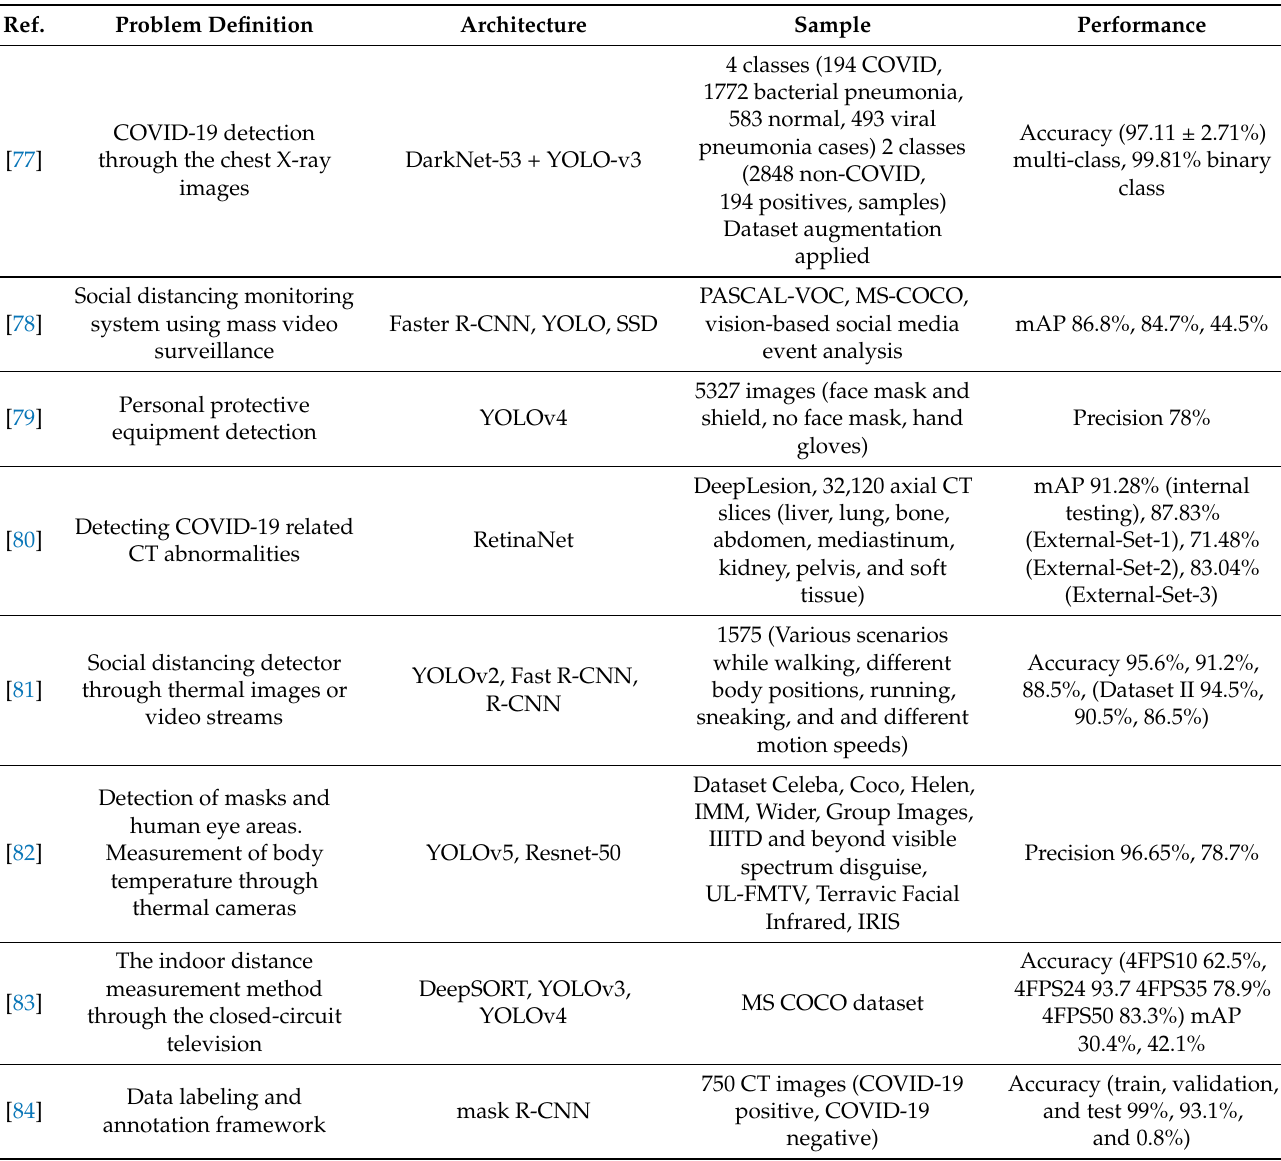
Table 2. The overview of applied object detection methods for COVID-19.